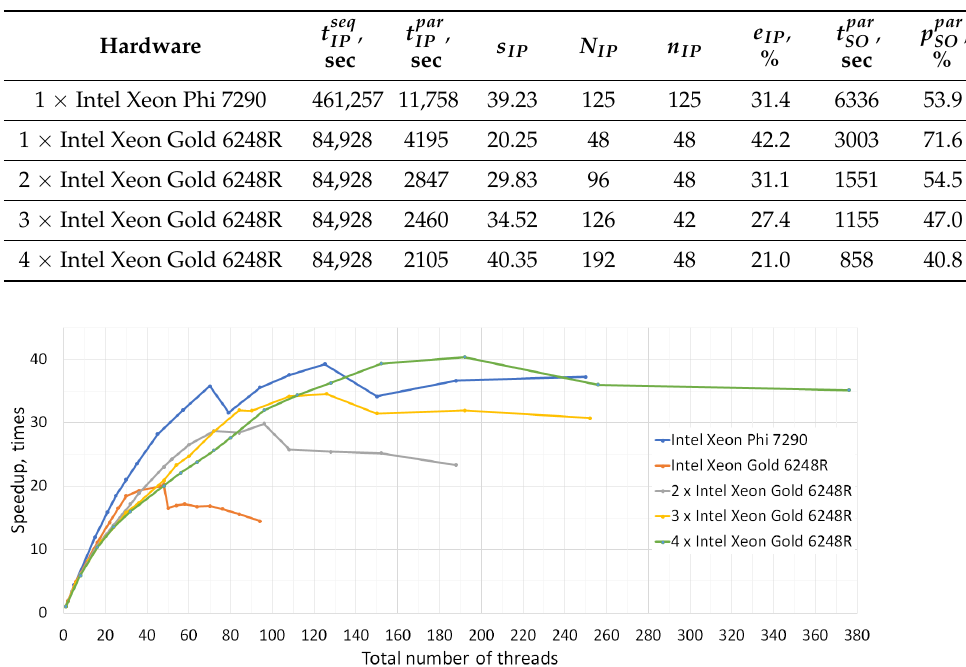
Table 2. Time results of the inverse problem solution on different hardware configurations: t seq is the IP time of the sequential inverse problem solution; t par is the best time of the parallel inverse problem IP / t par solution; s IP = t seq is the best speedup; N IP is the total number of threads with which the best IP IP speedup was achieved; n IP is the number of threads per node with which the best speedup was achieved; e IP = s IP / N IP is the parallelization efficiency for best speedup; t par is the time of sensitivity SO = t par operator’s matrix construction with N IP threads; p par / t par is the fraction of time of parallel IP SO SO inverse problem solution spent for the sensitivity operator’s matrix construction.